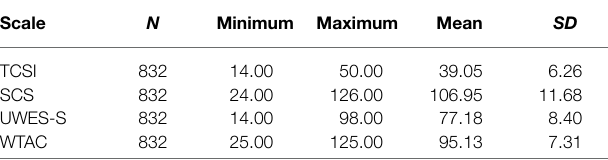
TABLE 2 | Descriptive statistics of the scales.